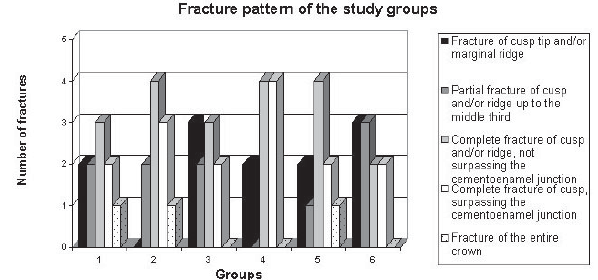
FIGURE 3- Graph representing the fracture pattern of the study